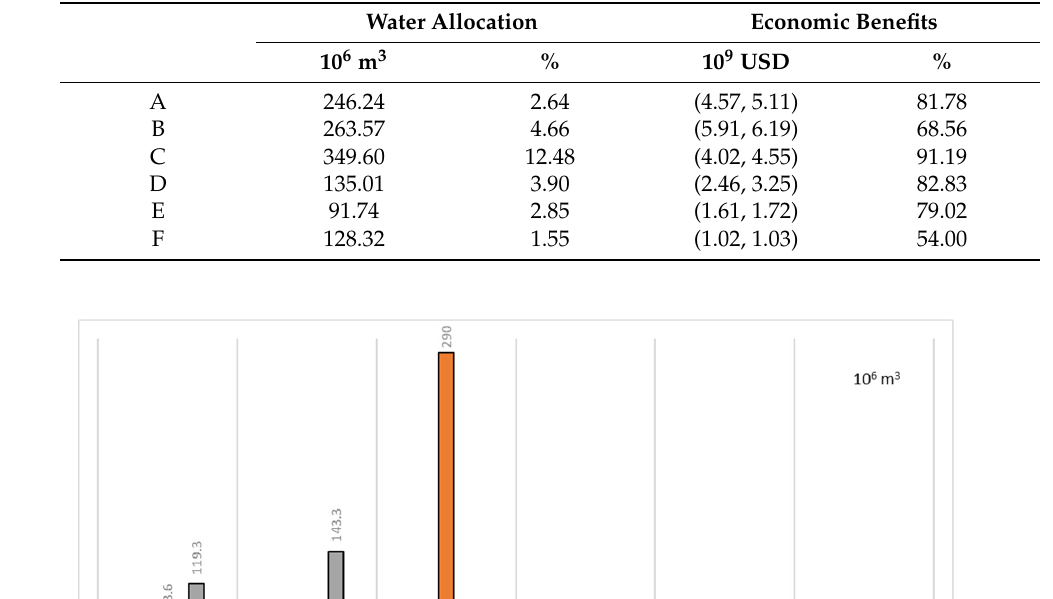
Table 12. Water allocation and economic benefits for three sectors of livestock, industry, and municipality.